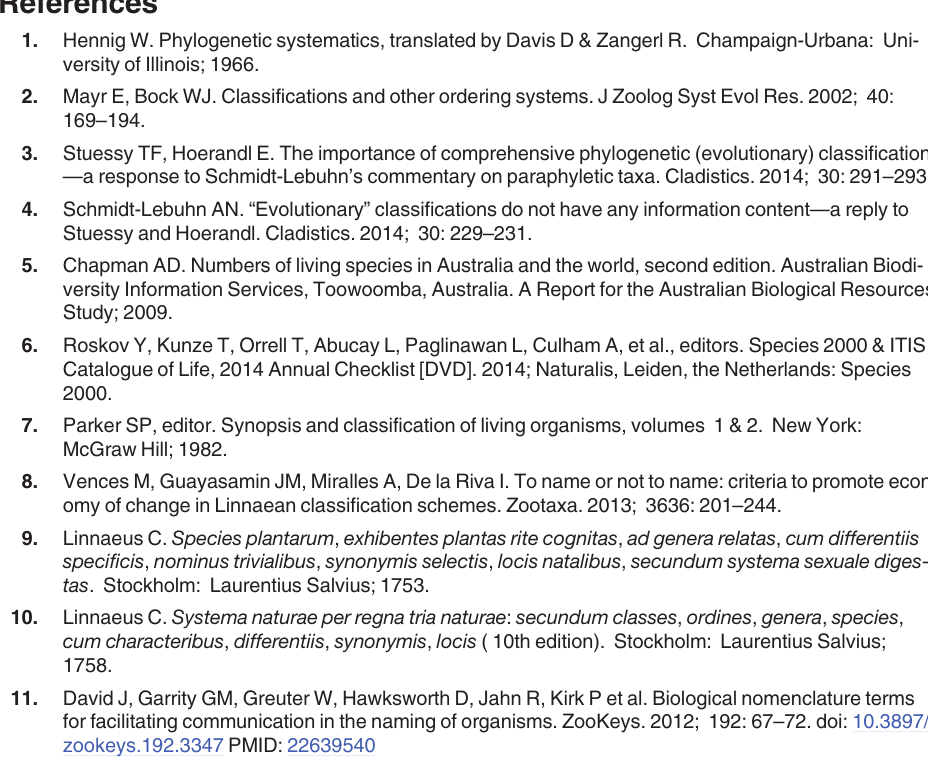
S1 Table. Proposed hierarchical classification from superkingdom to